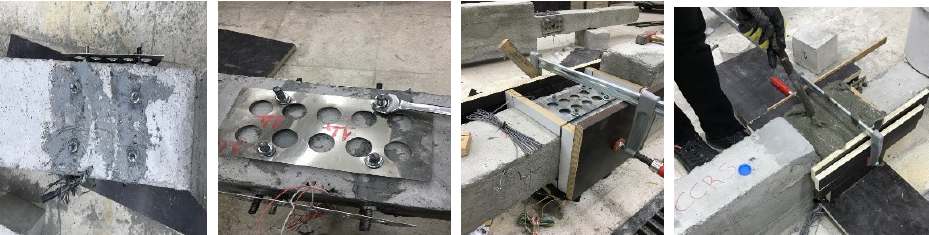
Figure 3. The production and application of the method.